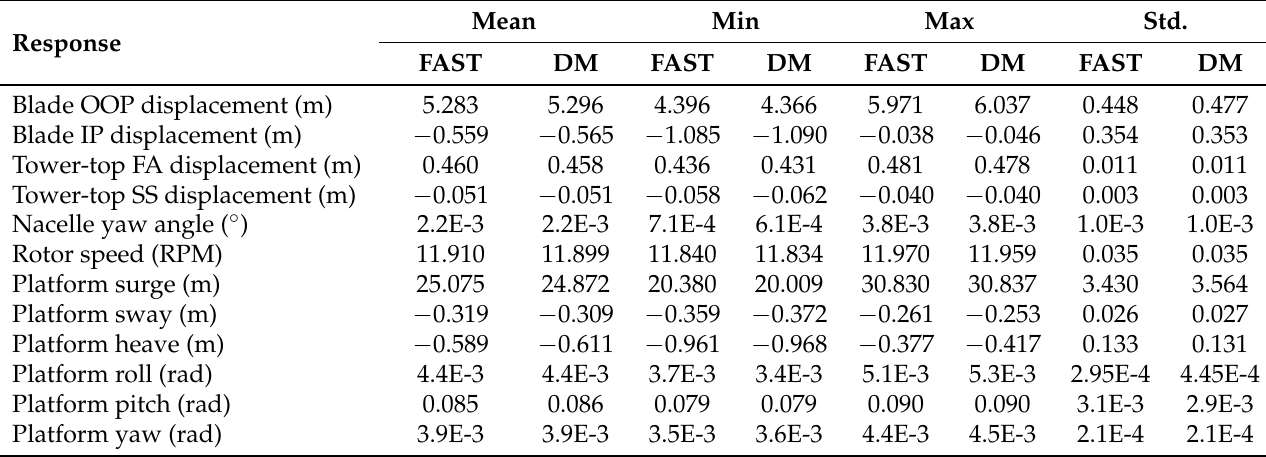
Table 2. Comparison of response statistic between FAST and the derived model